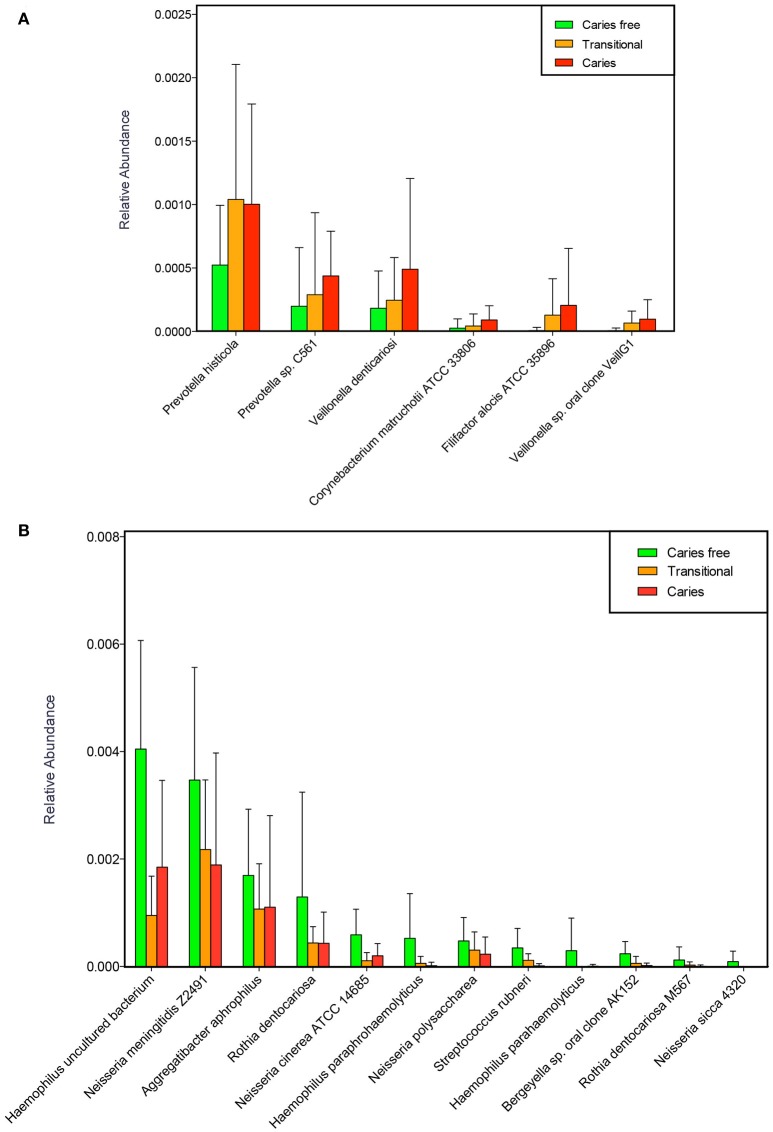
Species that up-regulated (A) and down-regulated (B) in the progression of dental caries.